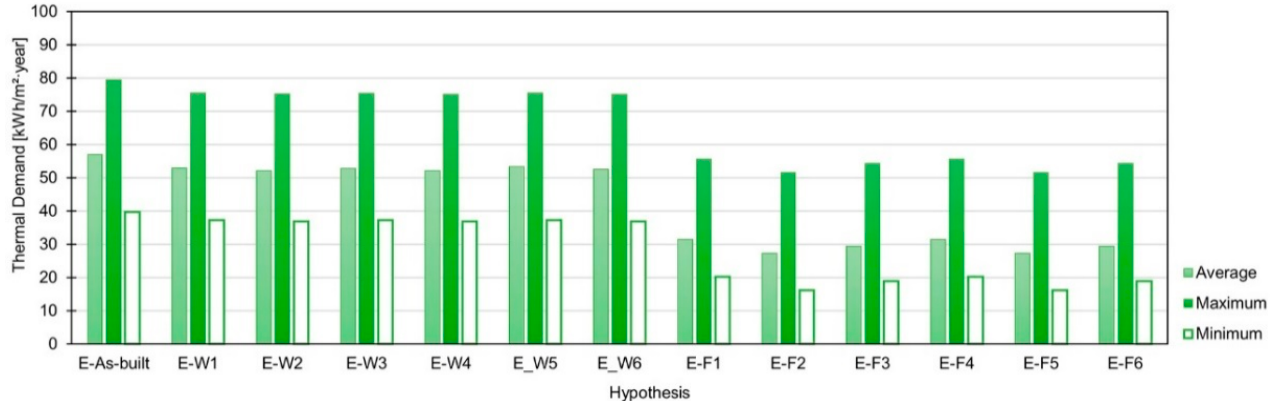
Figure 12. Normalised SDOF-NLS curves considering the S-RP2 solutions in the X- ( a ) and Y- ( b ) direction.